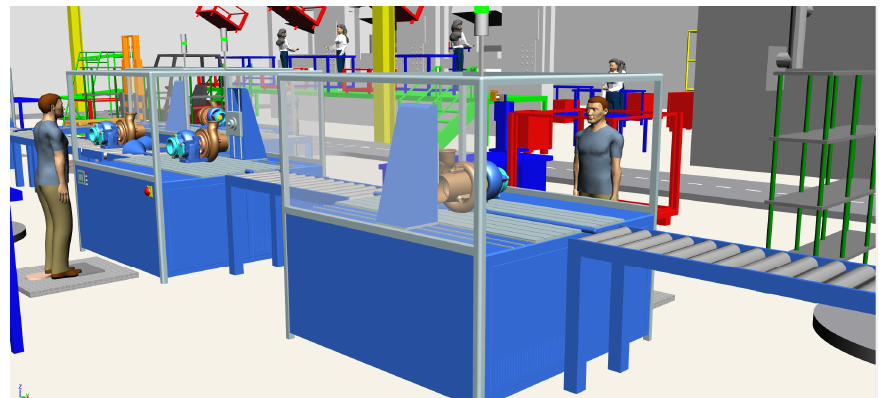
Figure 13. Digital factory detail of view used virtual reality technology with SIEMENS PLM technology.